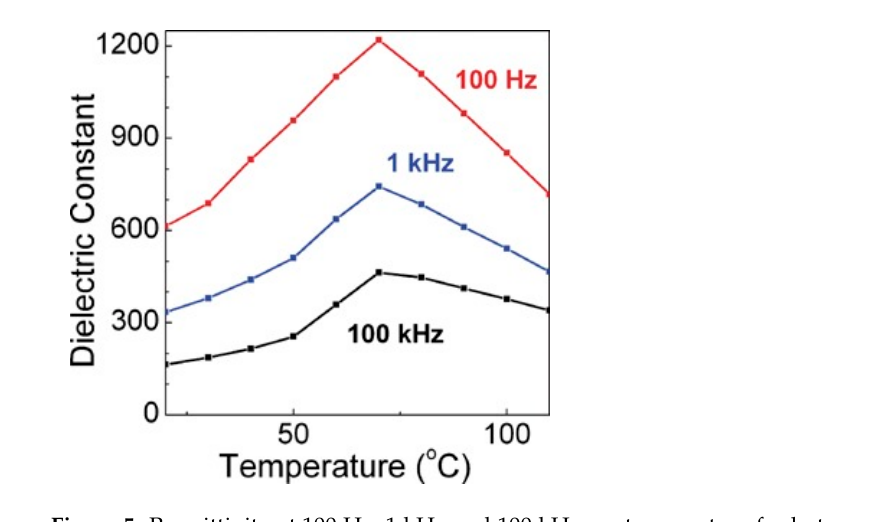
Figure 4. Frequency dependence of the permittivity and dissipation factor of c-BCB/BNNS with 10 vol% of BNNSs at different temperatures. Error bars show standard deviation. Reprinted with permission from [12]. Copyright 2015, Springer Nature.